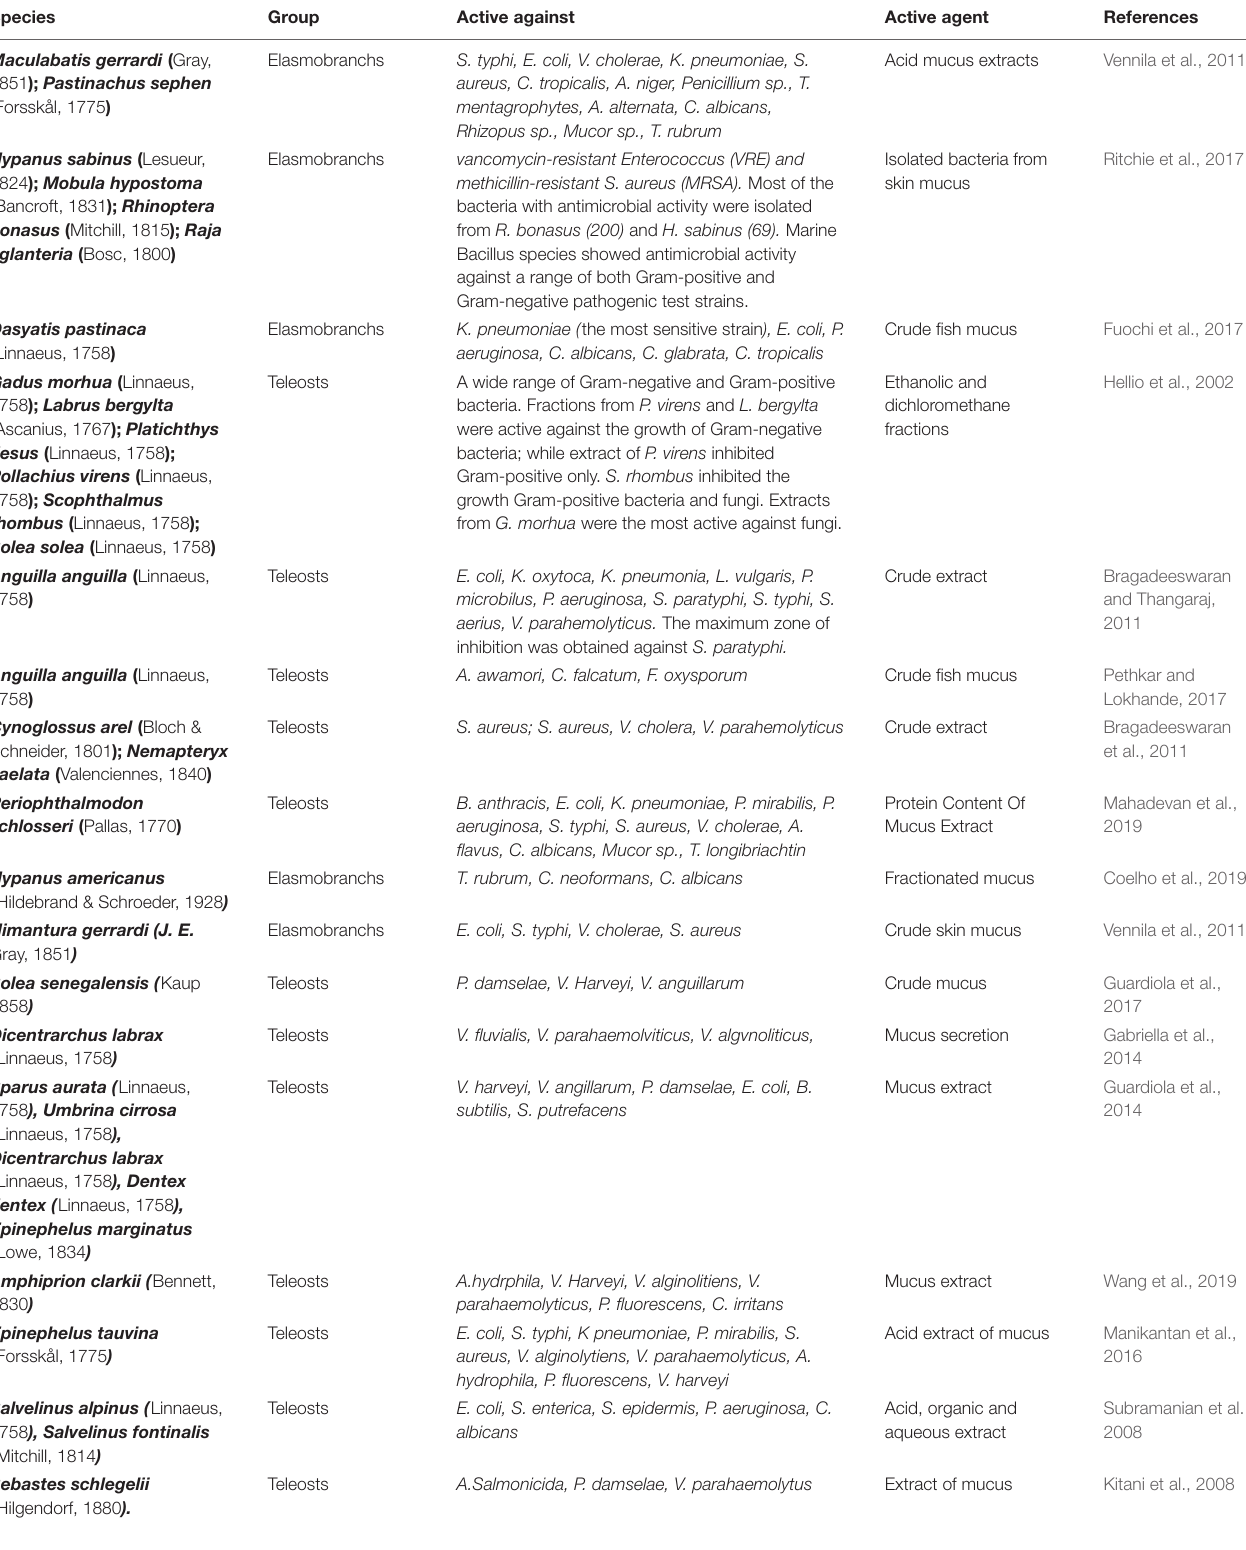
TABLE 1 | List of principal studies of skin mucus antimicrobial activities from elasmobranchs and teleosts.